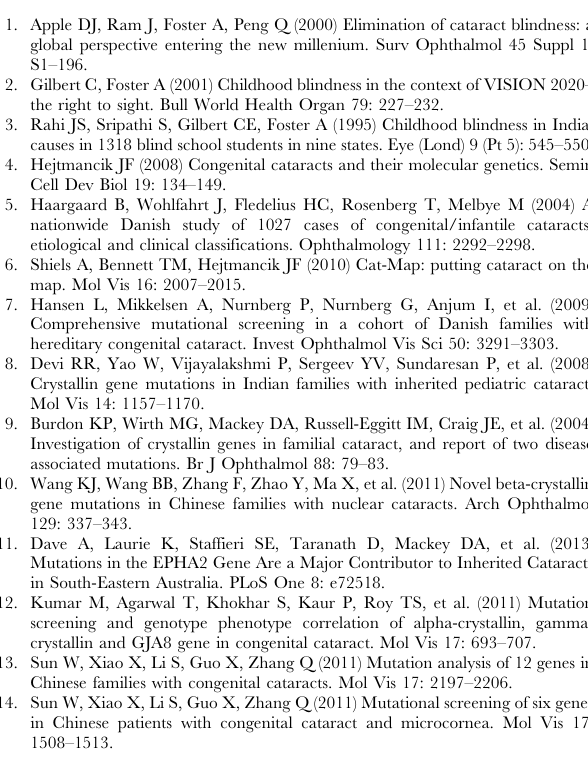
Table S1 Primers used to amplify and sequence the variants regions in this study. This table listed 12 pairs of primers which were used to amplify the genomic fragments with variants detected by exome